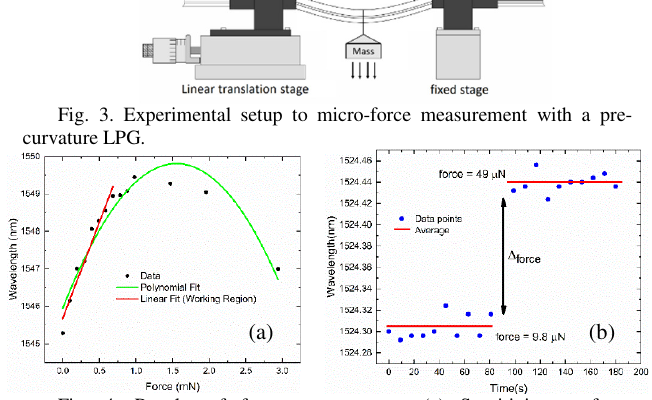
Fig. 4. Results of force measurement. (a) Sensitivity to force (5.14 nm/mN) for pre-curvature LPG (pre-curvature of 2.2 m -1 ). (b) Resolution measurement for forces of 9.8 μ N and 49 μ